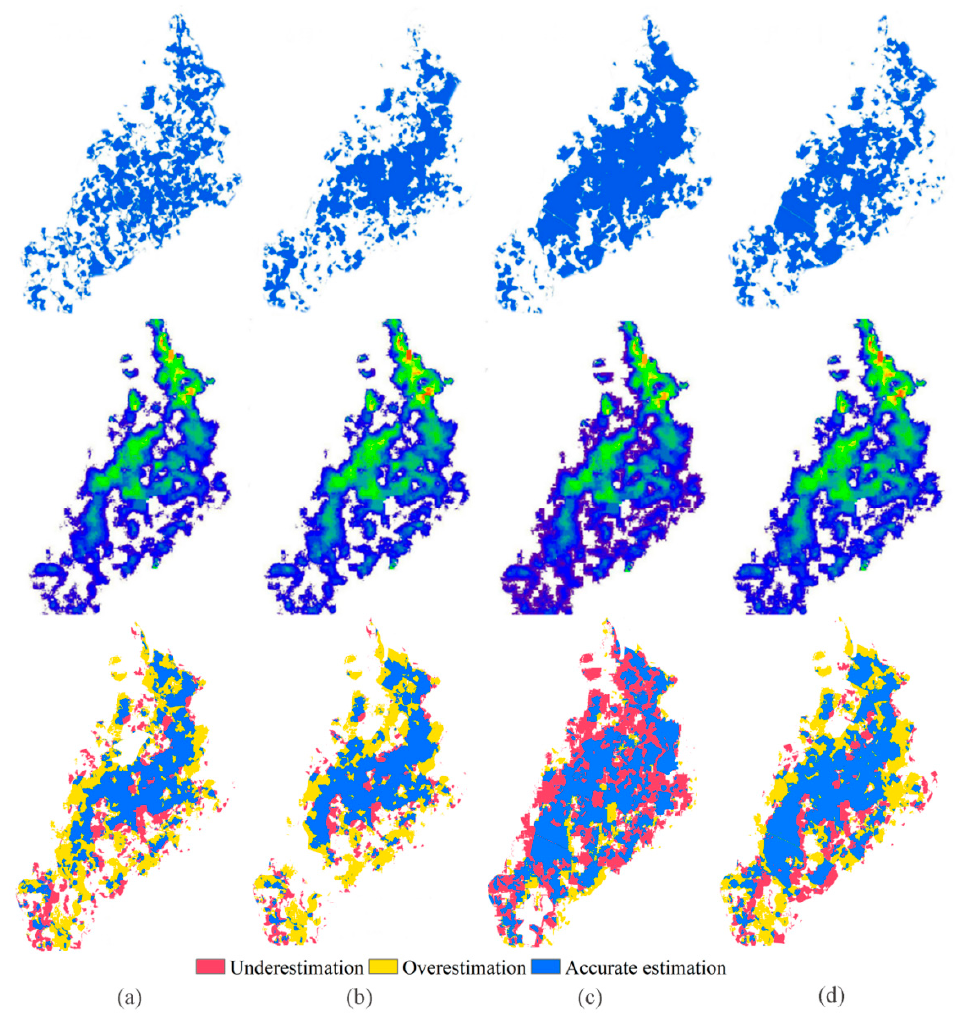
Figure 5. The flood extent derived from remote sensing data ( top ), the hydrodynamic model ( middle ) and the difference in inundation extents between the model and remote sensing observations for the ( a ) extremely dry period (1 May 2014), ( b ) flooding period (22 May 2014), ( c ) peak of the storm period (24 July 2014), and ( d ) flood recession period (10 September 2014). Table 4. Accuracy assessment of the flood extent derived from remote sensing data and hydrodynamic model in the Zhalong